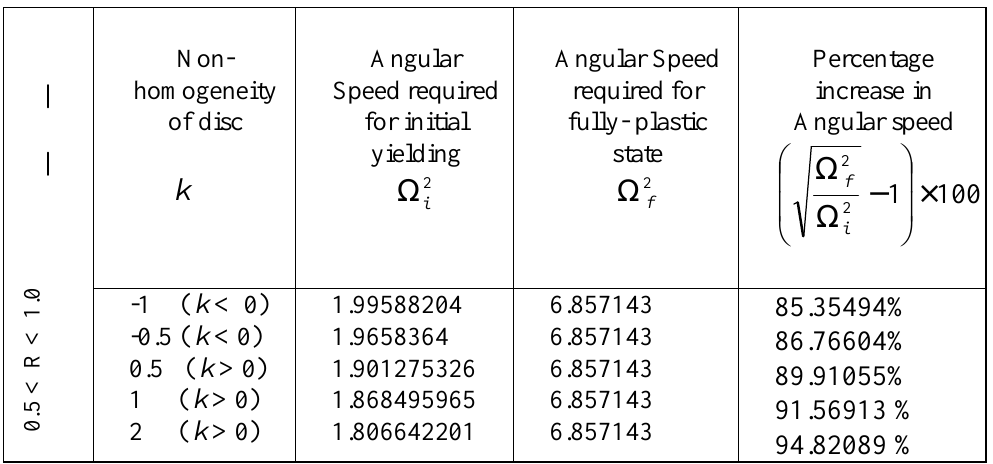
Table 1 : Angular speed required for initial yielding and fully plastic state